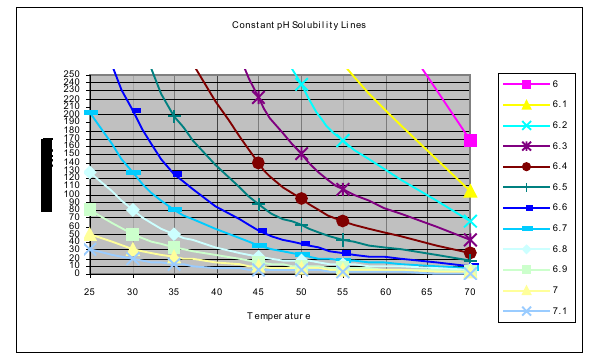
Figure 4: Copper solubility vs. temperature.